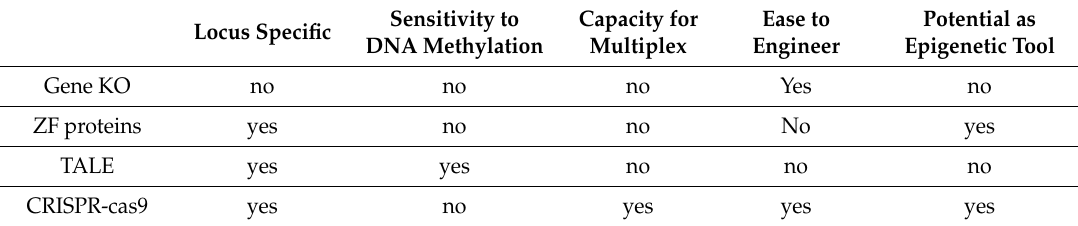
Table 3. Comparison of epigenetic editing